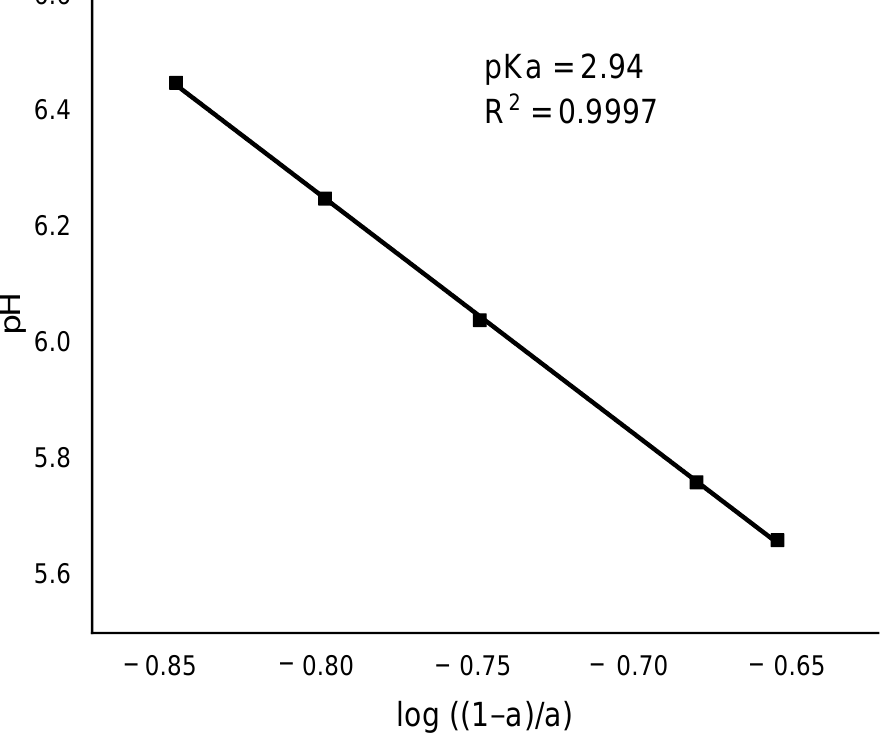
Figure 2. Linear regression to determine the pKa of Sargassum according to the Katchalsky model. The pKa was found to be 2.94, which corresponds to the mean pKa of the functional groups in the algal cell wall (e.g., fucoidan and polyalginates) and confirms the high adsorption capacity for heavy metals at pH values > 3